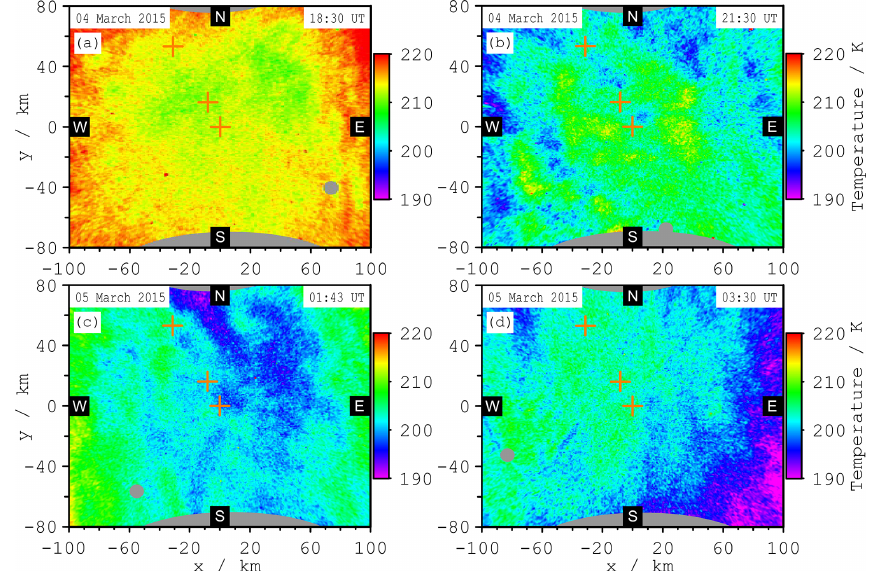
Figure 8. Temperature maps measured with the AMTM. In (a) , (b) , and (d) the typical situation during the observation time is shown. (c) shows the situation at the rocket launch time. Very low gravity wave activity is apparent, which was the typical condition during this night.